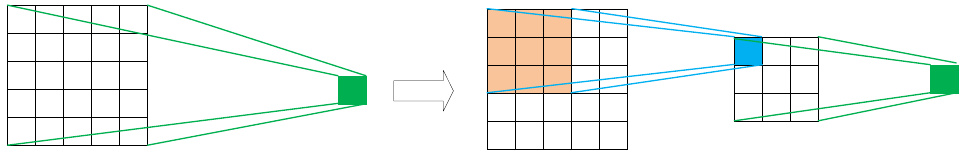
Figure 11. The schematic diagram of 5 × 5 multi-layer small-scale cascade pooling.